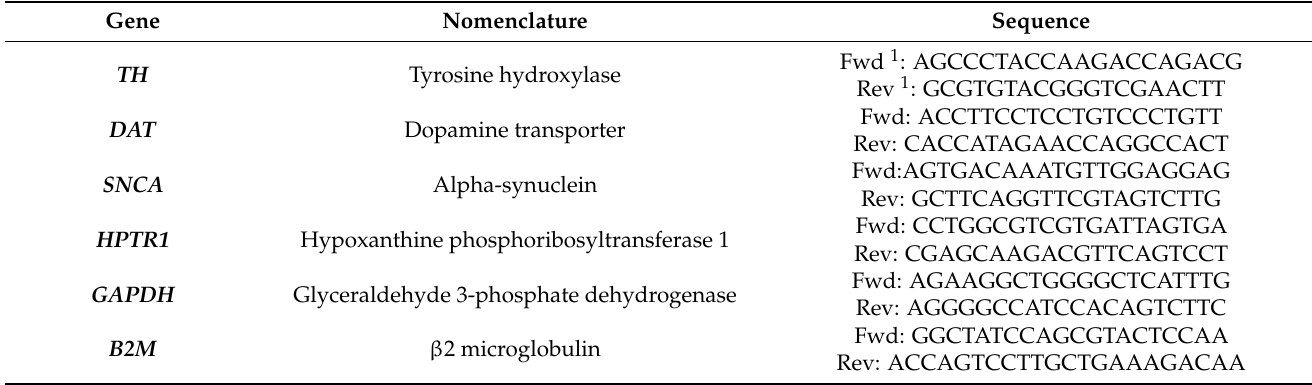
Table 1. List of oligonucleotide primers used for RT-qPCR